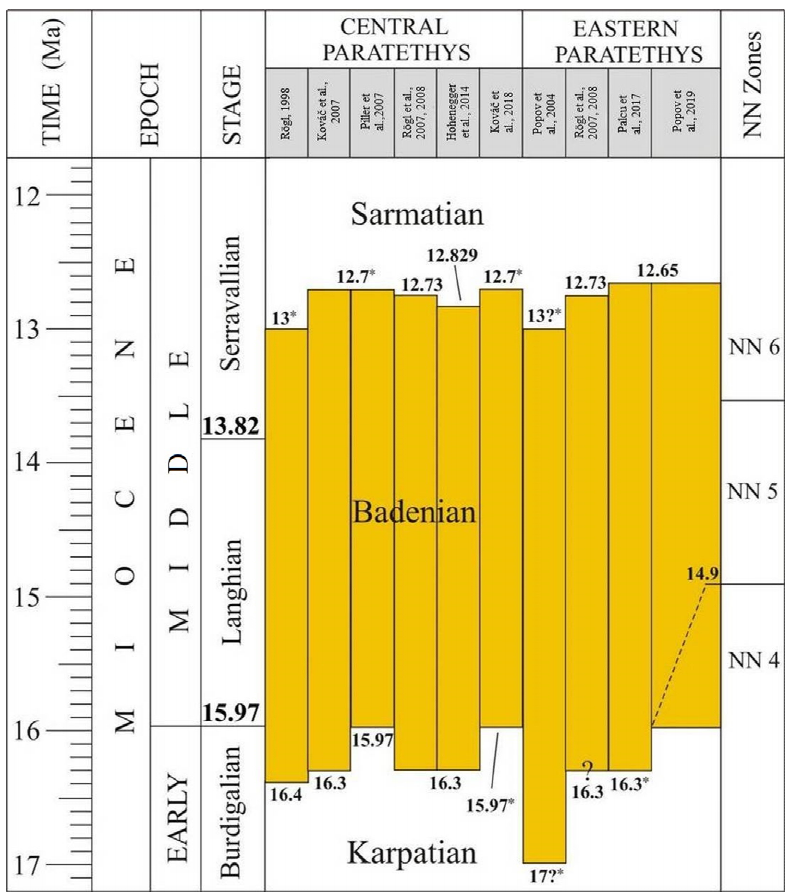
Figure 20. Absolute age of the Langhian/Serravallian, Karpatian/Badenian and Badenian/Sarmatian boundaries, proposed by the various authors. Asterisks (*) point to the ages derived from figures, not explicitly written in papers ([2,4,21,25,26,34,151,160,164,175]). For more information see Figure S1. At the locality Marija Bistrica, situated near the fault zone in NE Medvednica